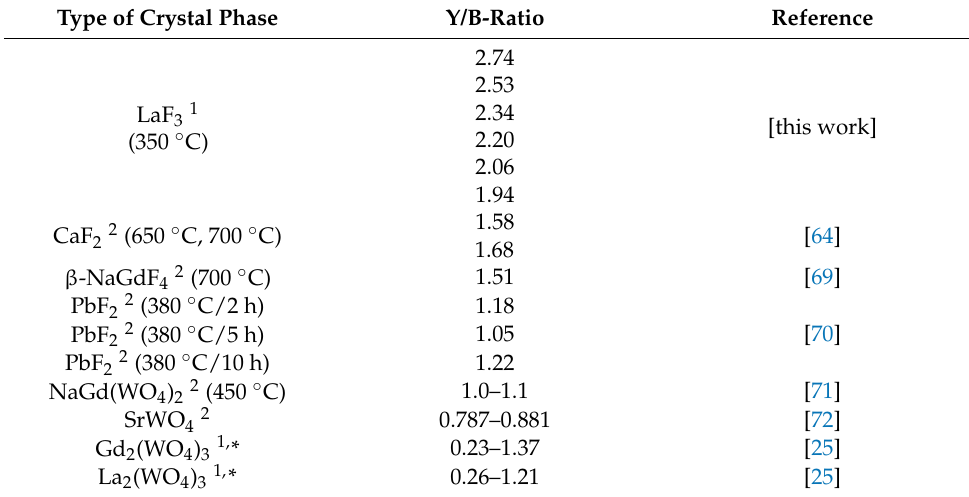
Table 5. Y/B-ratios for glass-ceramics doped with Dy 3+ ions. Type of Crystal